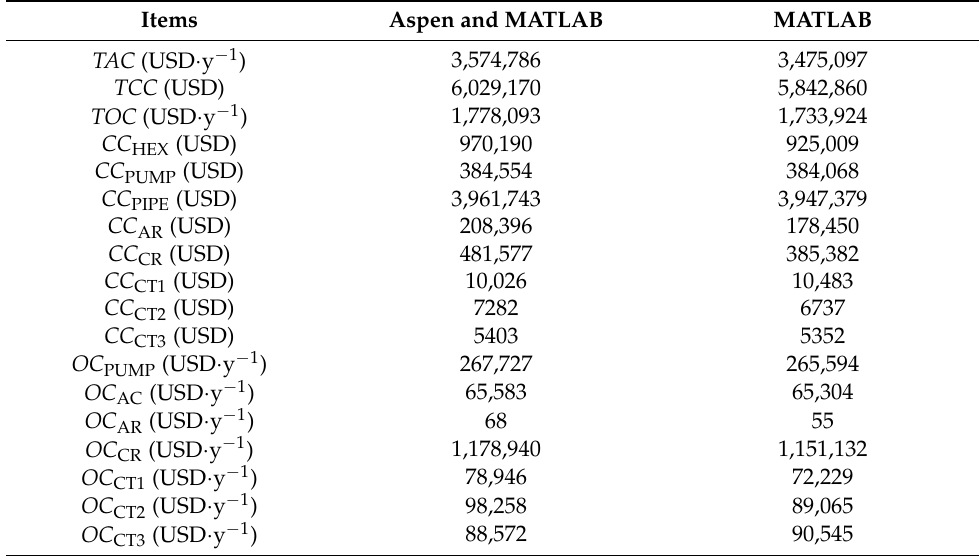
Table 10. Comparison of optimization results of cascade cooling system with different